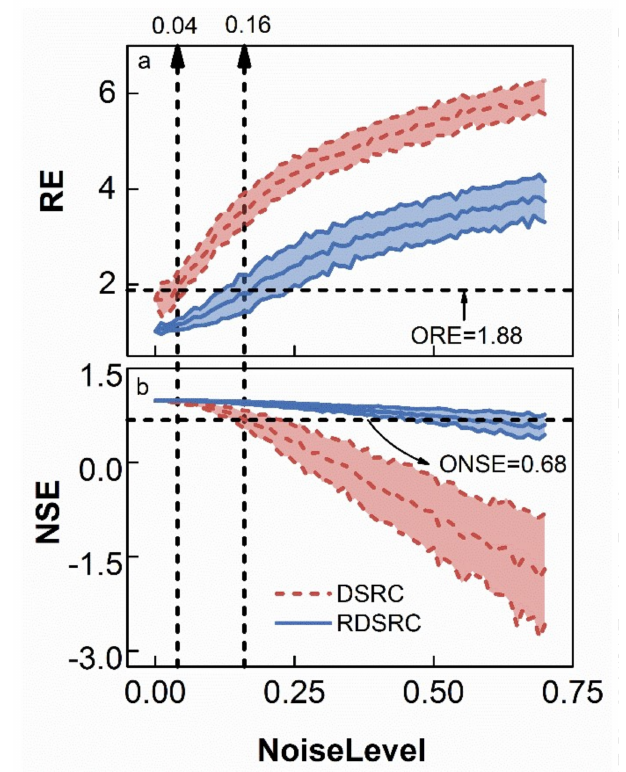
Figure 7. Plots of 71 sets of RE and Nash–Sutcliffe efficiency ( NSE ) for updating free water storage. The labels “ORE” and “ONSE” represent the RE and NSE of the original simulations (free of updating), respectively. The straight line in the middle represents mean values of 100 flood events (per level), and half the width of the filled area represents the corresponding standard